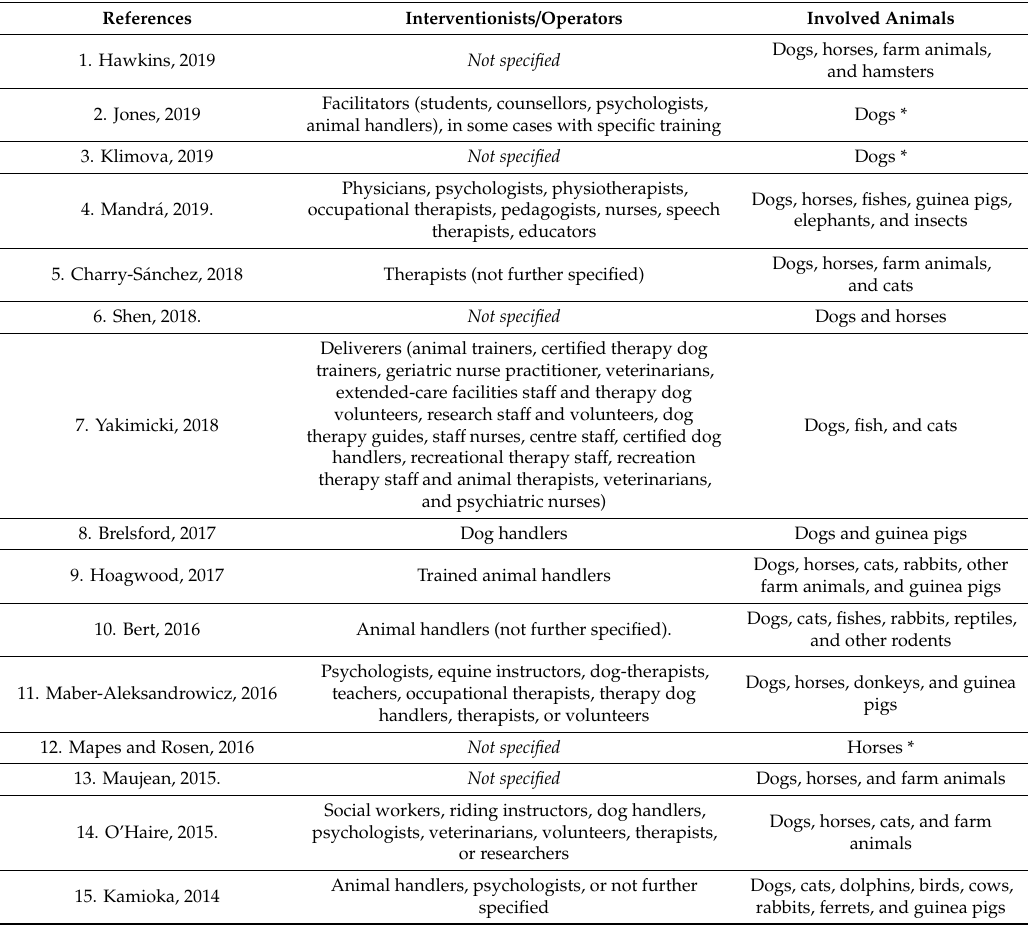
Table 4. Involved interventionists / operators and